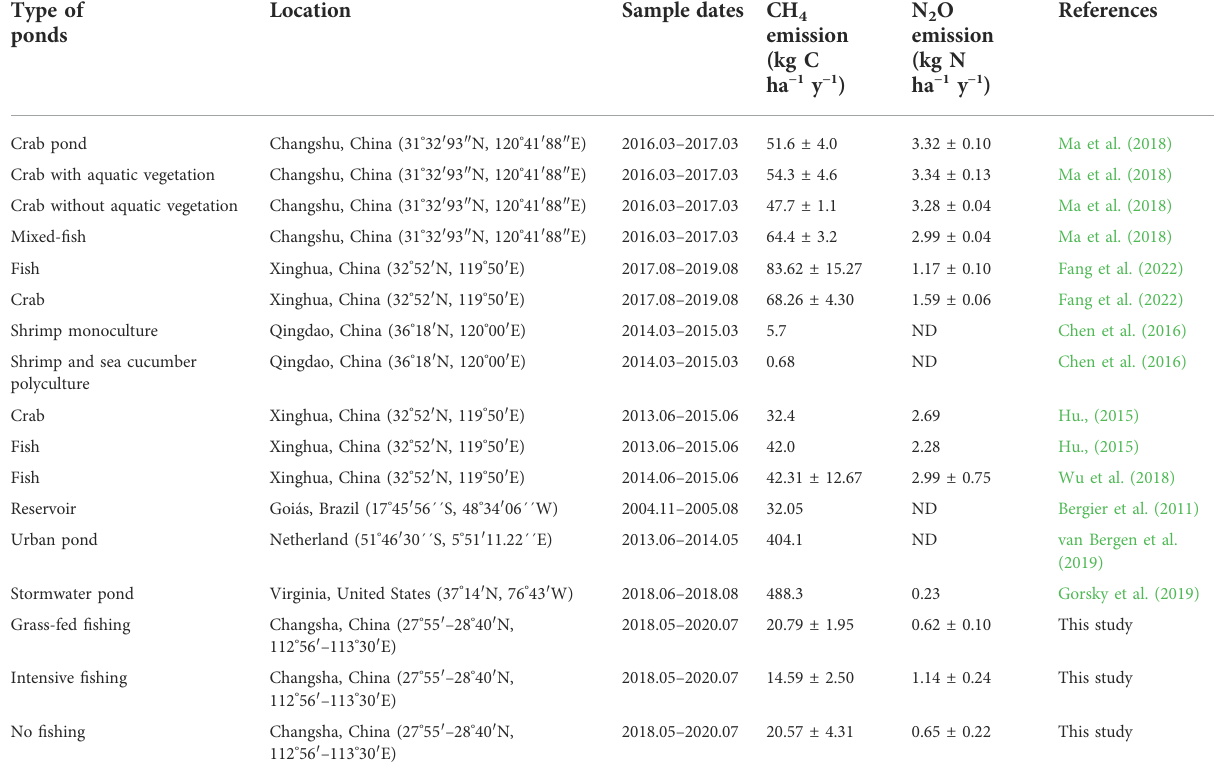
TABLE 4 Comparison of CH 4 and N 2 O emission fl uxes from pond and reservoir